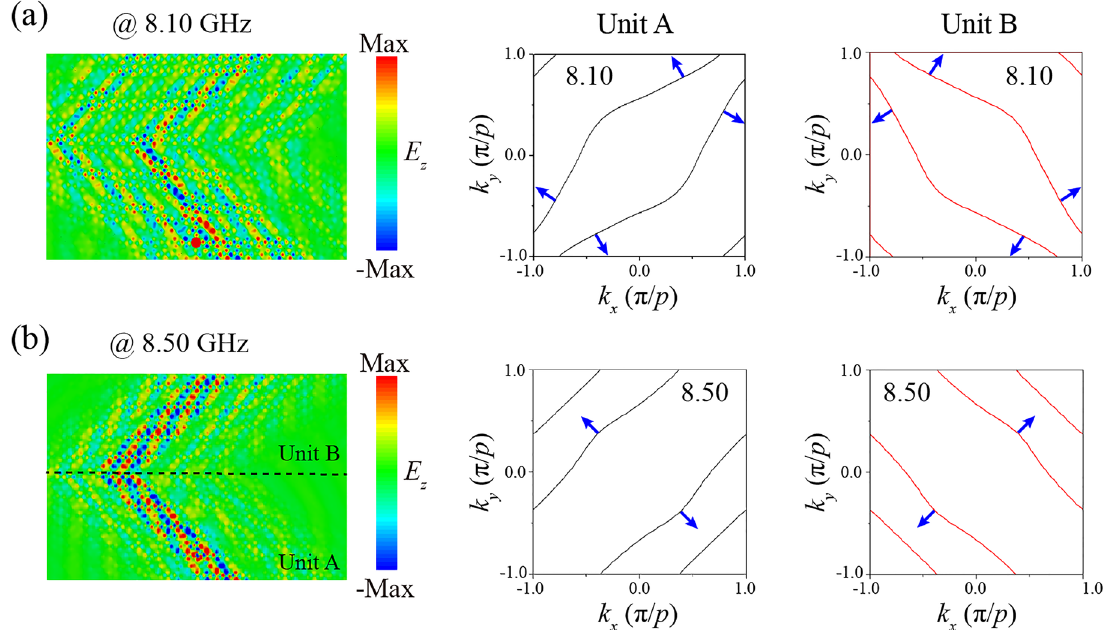
Figure 6: Calculated E z distributions in the xy plane at 0.05 mm above the integrated structureandthe correspondingIFCs at (a) 8.10 GHzand (b) 8.50 GHz,